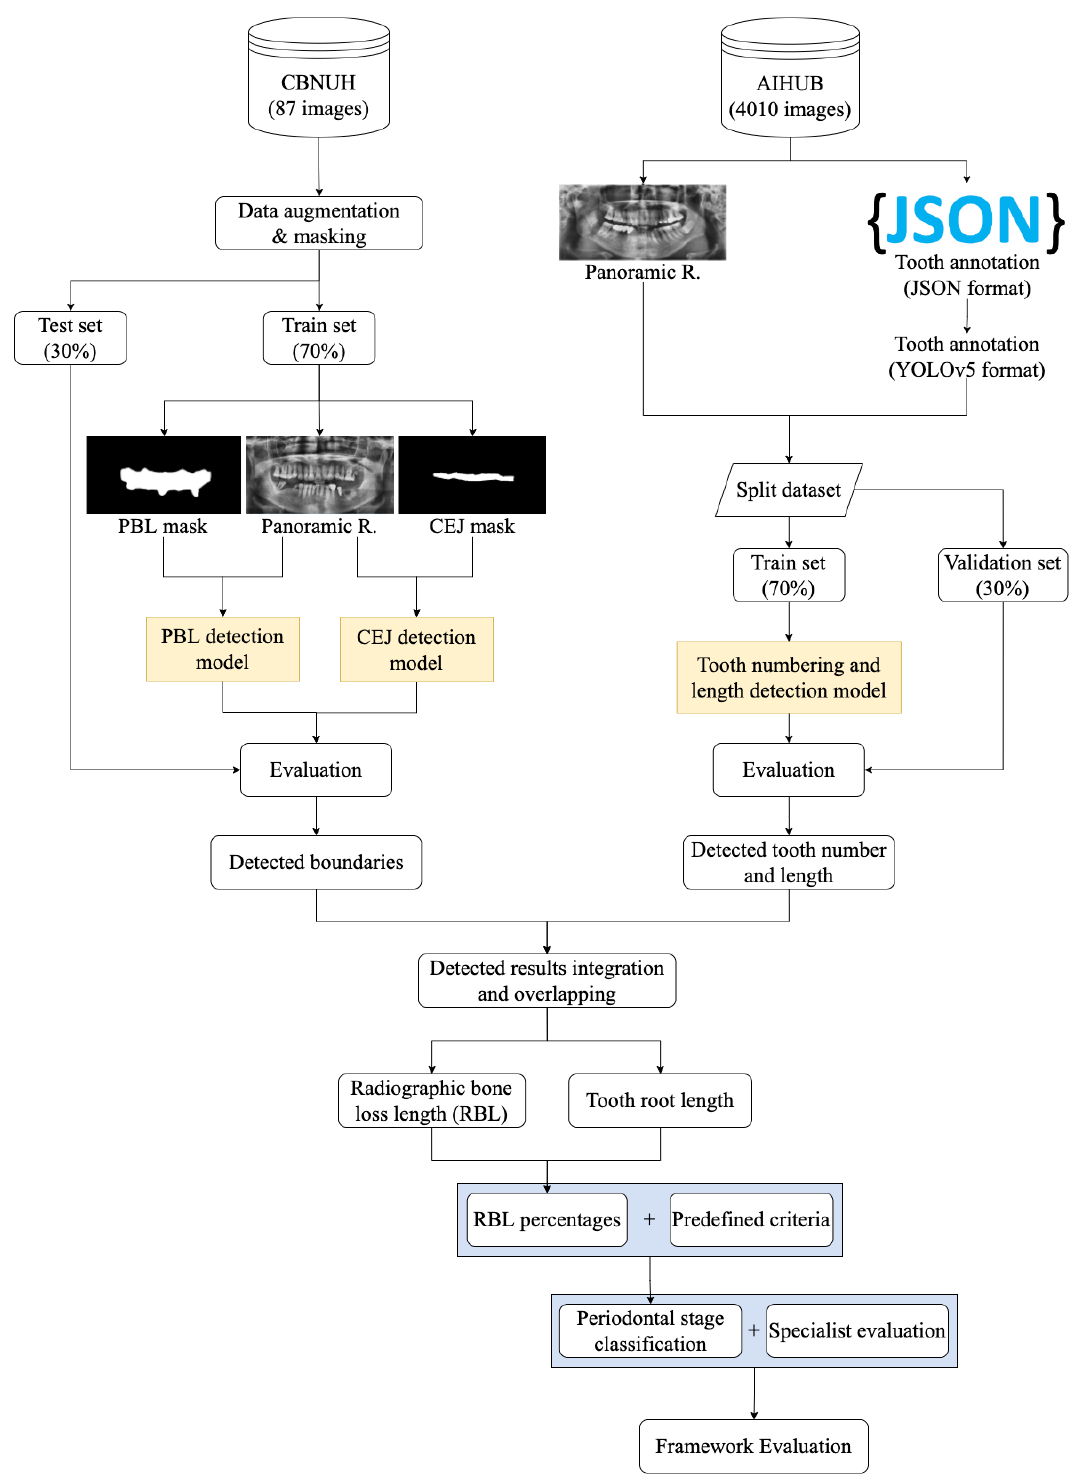
Figure 3. Integrated model framework using deep learning algorithms for periodontitis stage classification.